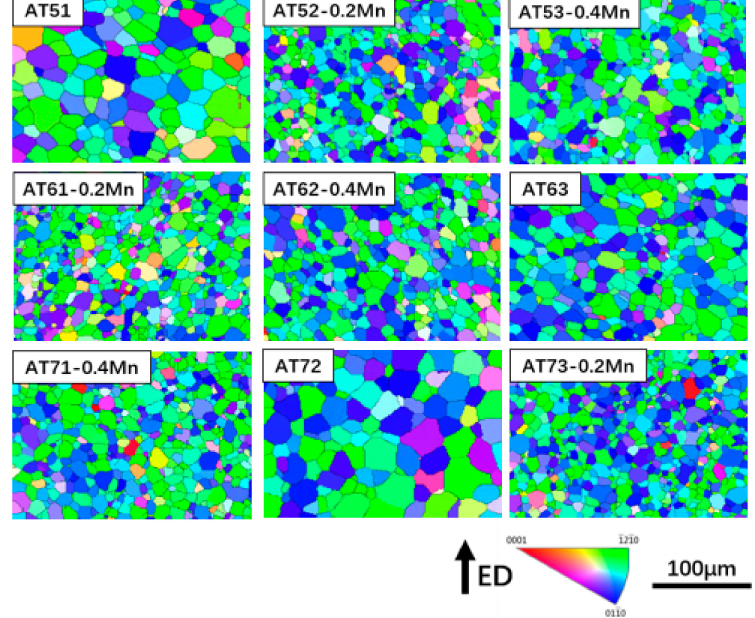
Figure 4. Electron backscatter diffraction (EBSD) inverse-pole figure maps of extruded Mg-Al-Sn-Mn magnesium